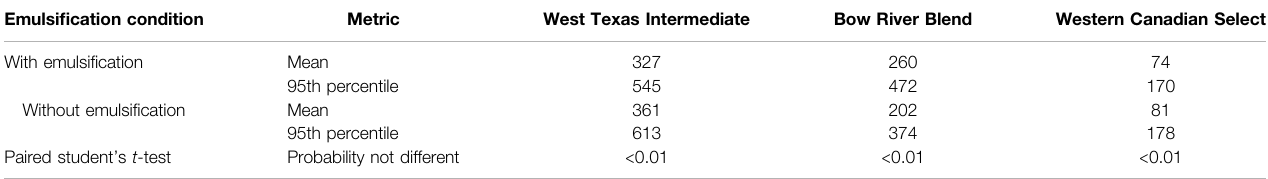
TABLE 6 | Expected exposure to ≥ 1 μ g/L (1 ppb) dissolved concentrations, as the sum of concentration multiplied by duration of exposure (dose, µg/L-hours) over the simulation, for a surface release of 200 MT, based on results for 114 simulations varying spill date. Emulsi fi cation condition